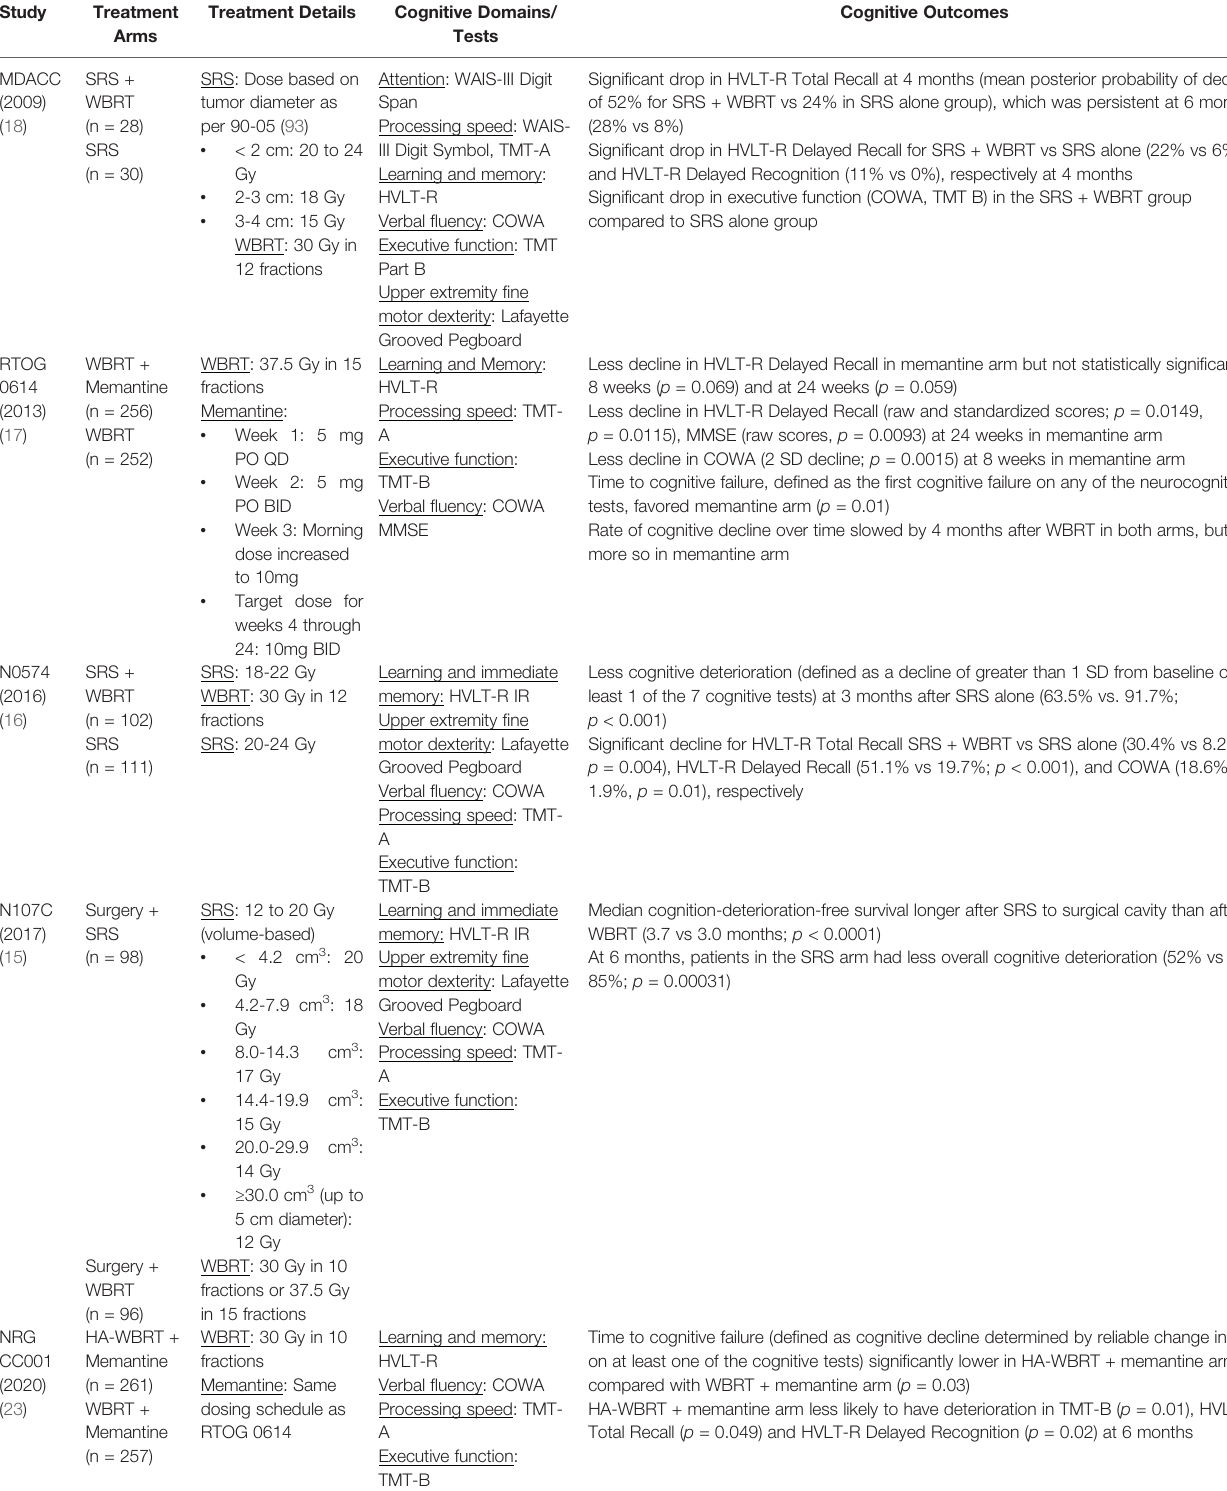
TABLE 1 | Phase 3 Studies Utilizing Stereotactic Radiosurgery or Memantine/Hippocampal Avoidance in Patients with Brain Metastases Incorporating Neuropsychological Testing.